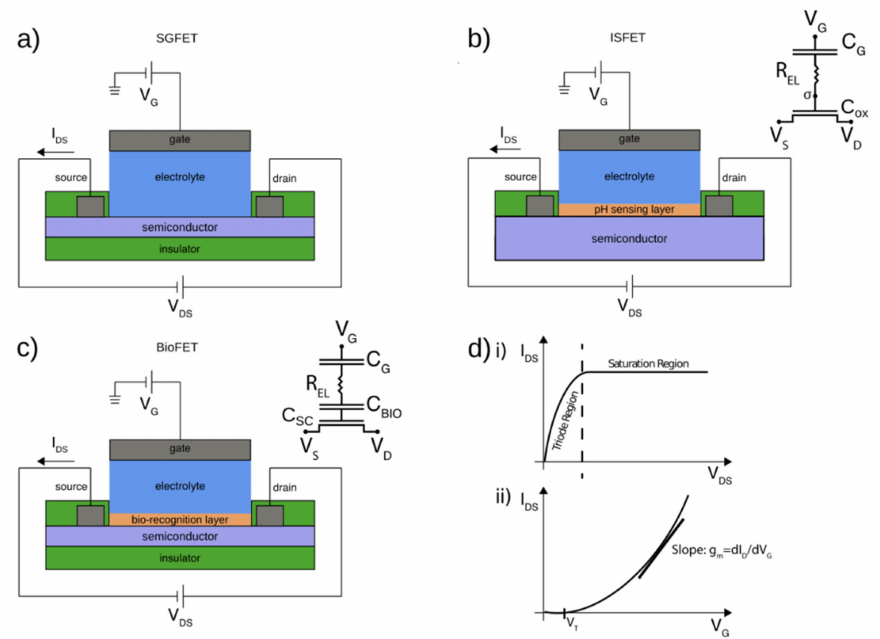
Figure 1. Schematic representation of ( a ) solution-gated field-effect transistor (SGFET), ( b ) ion- sensitive field-effect transistor (ISFET), and ( c ) field-effect transistor-based biosensor (BioFET) with their equivalent circuits, respectively. ( d ) The characteristic curves of the SGFET, output ( i ) I DS vs. V DS and transfer ( ii ) I DS vs. V GS . Adapted from [52] with permission from